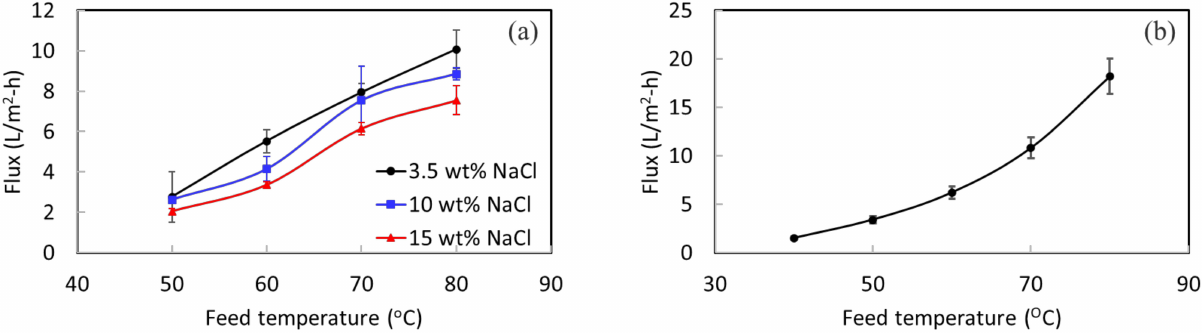
Figure 4. ( a ) DCMD flux under different feed temperatures and concentrations, and ( b ) VMD flux at different temperatures with a 3.5 wt% NaCl